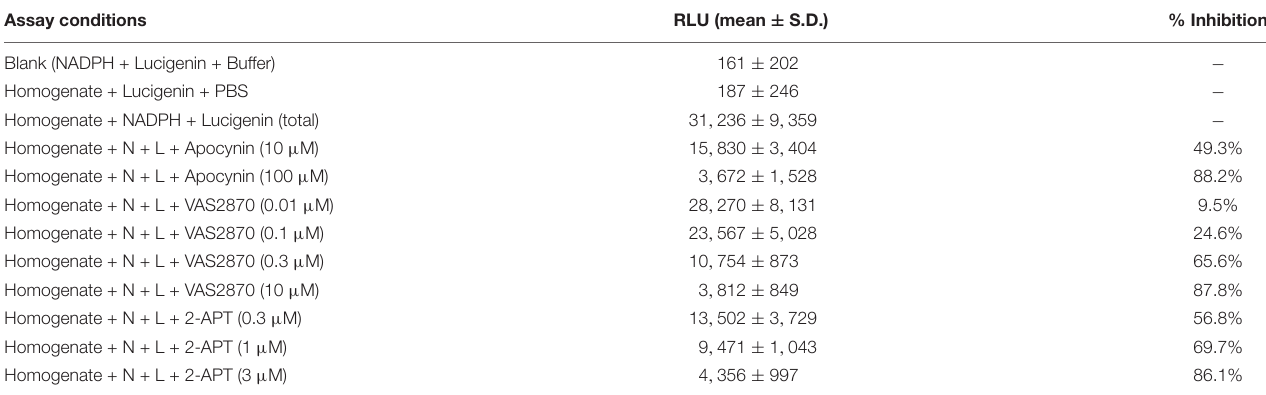
TABLE 2 | Inhibition of NADPH-oxidase (NOX) enzyme activity by apocynin, 2-APT and VAS2870 in Sprague–Dawley rat aortic homogenates. Assay conditions RLU (mean ± S.D.) % Inhibition Blank (NADPH + Lucigenin +